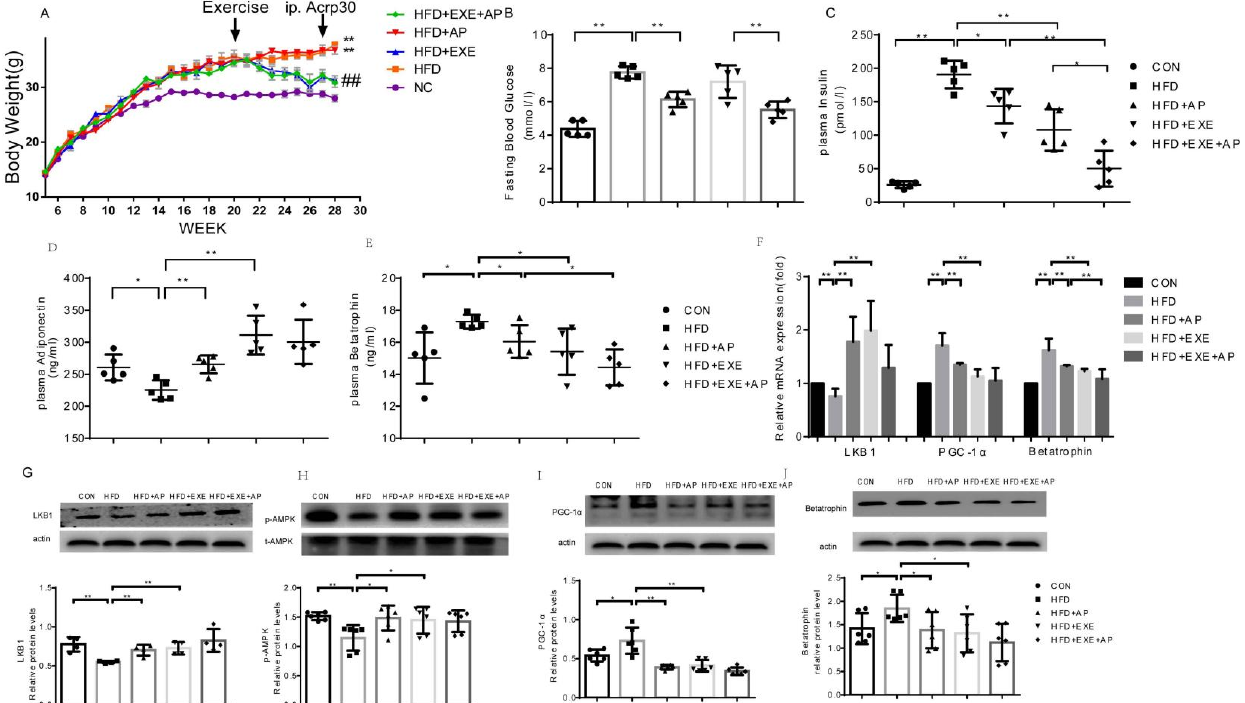
Figure 4. Exercise inhibits betatrophin expression and improves insulin sensitivity in obese mice. Mice fed a high-fat diet (HFD) were randomly allocated to HFD, HFD + Acrp30, HFD + EXE, or HFD + Acrp30 + EXE groups. ( A ) Body weights of HFD mice in the different intervention groups were recorded at regular intervals. ( B ) Fasting blood glucose concentration. ( C ) Serum insulin levels. ( D , E ) Plasma concentrations of adiponectin and betatrophin determined using ELISA at the end of the interventions (n = 6–8 in each group). ( F ) mRNA expression levels of Lkb1, Ppargc1a, and Angptl8 in the liver were measured using RT-qPCR. All PCRs were performed in triplicates in at least three independent experiments. ( G – J ) Western blot analysis of LKB1, p-AMPK, PGC-1 α , and betatrophin expression in mouse liver. The HFD+Acrp30+EXE group received an i.p. injection of either Acrp30 (28 µ g kg − 1 day − 1 ) or saline for the last week of exercise training. Data from at least three independent experiments are shown, and all data are expressed as the mean ± standard deviation. Student’s t test: * p < 0.05, ** p < 0.01, ## p <